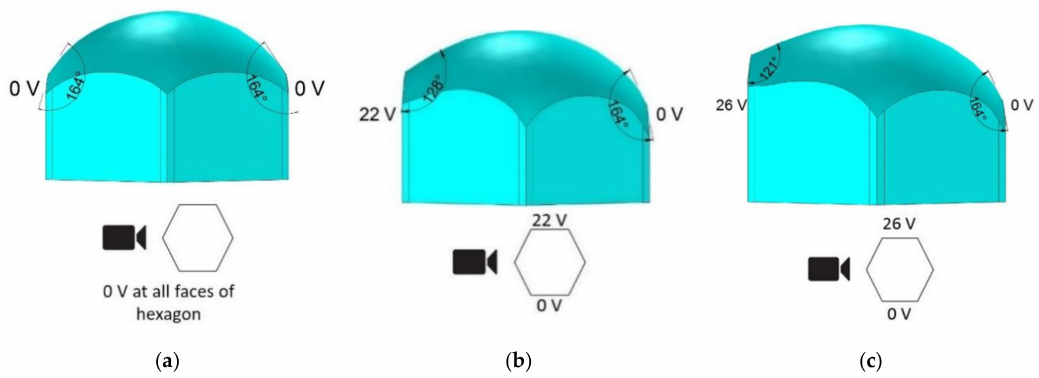
Figure 10. The simulation result (front view) of the bottom liquid (water) interface in a hexagonal electrowetting cell with ( a ) 0 V, ( b ) 22 V, and ( c ) 26 V applied to the cell’s left electrode face.